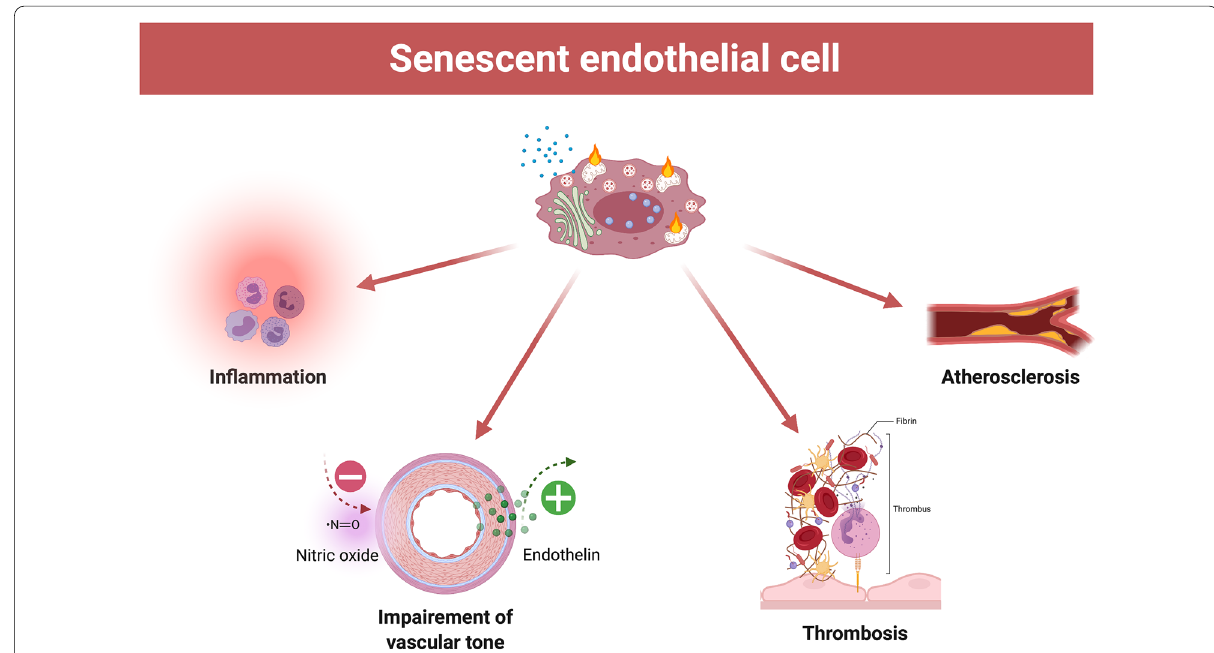
Fig. 4 Features of dysfunctional senescent endothelial cell. Accumulation of senescent endothelial cells impedes vascular homeostasis. Main consequences include a progressive acquisition of an inflammatory endothelial phenotype, a procoagulant state, a proatherogenic phenotype, and the loss of vascular tone with reduced NO availability and increased release of endothelin. NO nitric